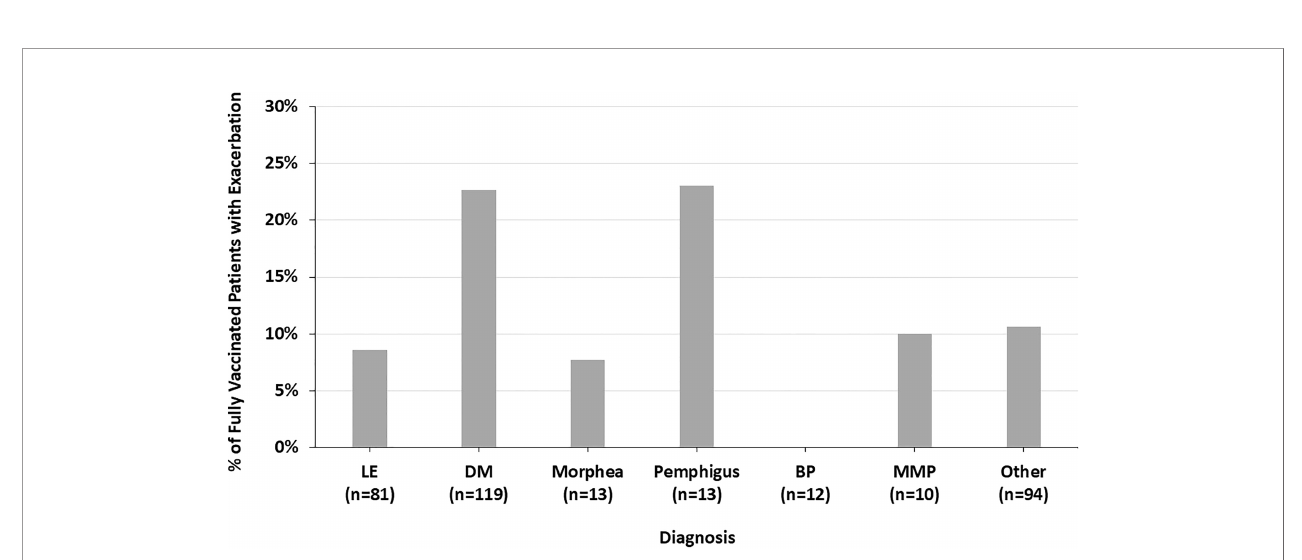
FIGURE 1 | The percent of fully vaccinated patients reporting symptoms of autoimmune disease exacerbation after the COVID-19 vaccine by diagnosis, highlighting the higher incidence in dermatomyositis patients compared to lupus erythematosus patients. **P ≤ 0.01.